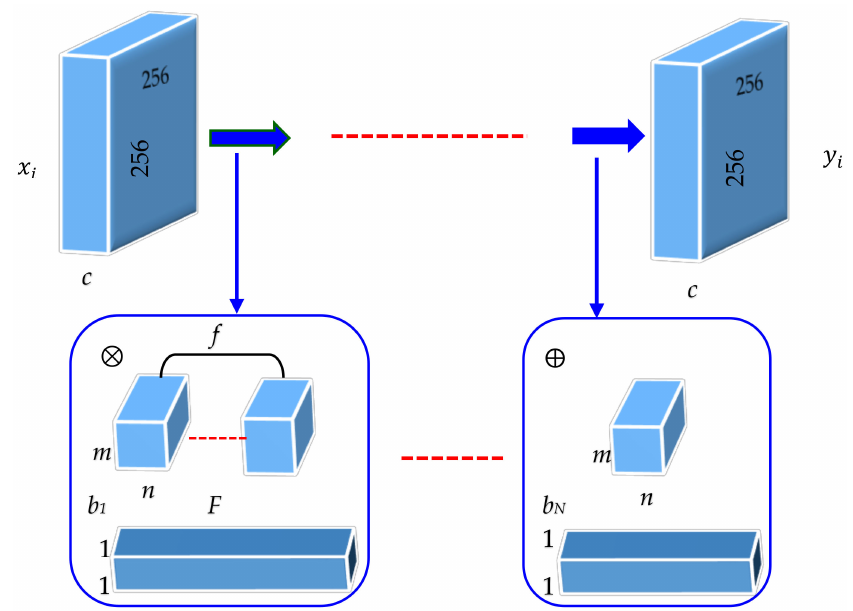
Figure 2. A schematic illustration of FSCN architecture in which 256 × 256 pixel gray images are used for